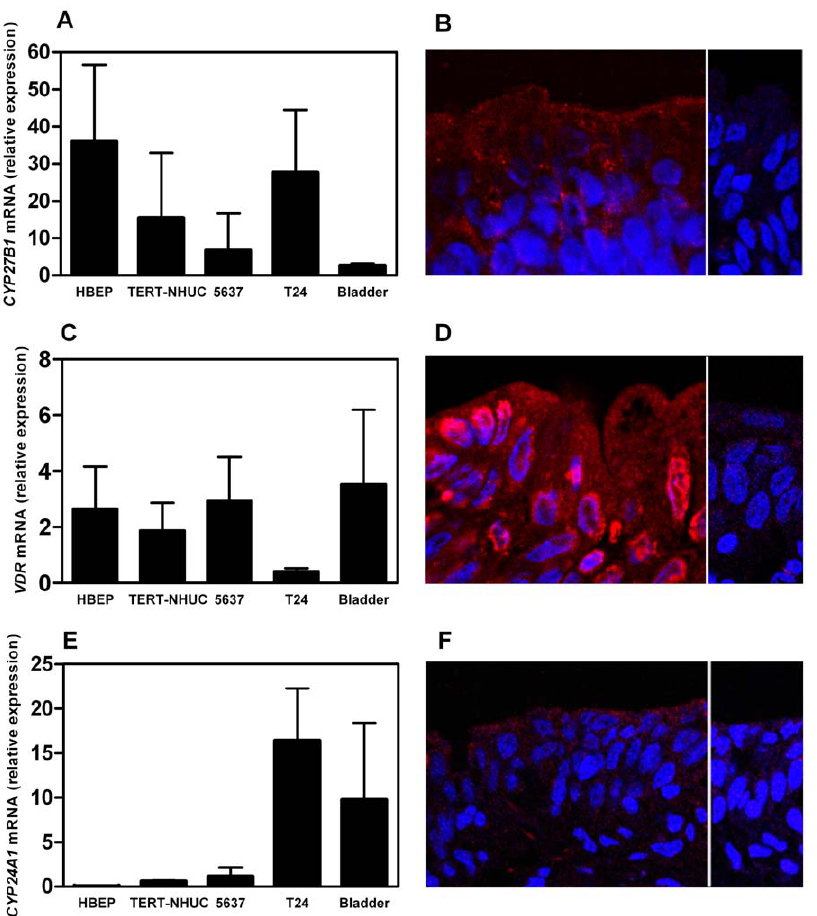
Figure 3. Bladder epithelial cells are equipped with the machinery for local 25D 3 conversion and activity. Expression of CYP27B1, VDR and CYP24A1 was detected on mRNA level in normal bladder cells (HBEP) and three bladder cells lines (TERT-NHUC, 5637 and T24) by RT-PCR ( A , C , E ) and on protein level in tissue from bladder biopsies by fluorescence immunohistochemistry ( B , D , F ). mRNA expression results were normalized to expression in the kidney epithelial cell line A498. The proteins are stained with AlexaFluor 594 (red), the cell nucleus with DAPI (blue). CYP27B1 protein was detected in the bladder mucosa where it was evenly distributed in the bladder epithelial layers with an abundance of staining seen in the peri-nuclear area, consistent with its association to mitochondria ( B ). VDR protein was localized in the cytoplasm and nucleus ( D ). Low levels of the CYP24A1 protein were detected in bladder mucosa ( F ). All images are captured at 6 63 magnification and the right panels of images B, D and F show controls stained without primary antibodies against CYP27B1, VDR and CYP24A1, respectively.